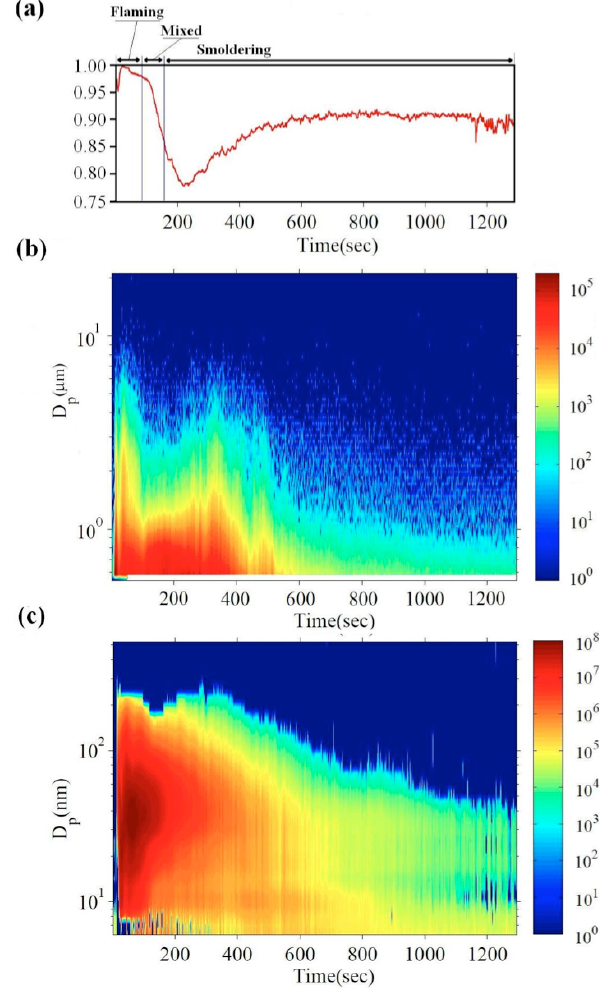
Fig. 7. (a) Modified Combustion Efficiency (MCE); Corresponding APS (b) and FMPS (c) contour graphs showing particle number size